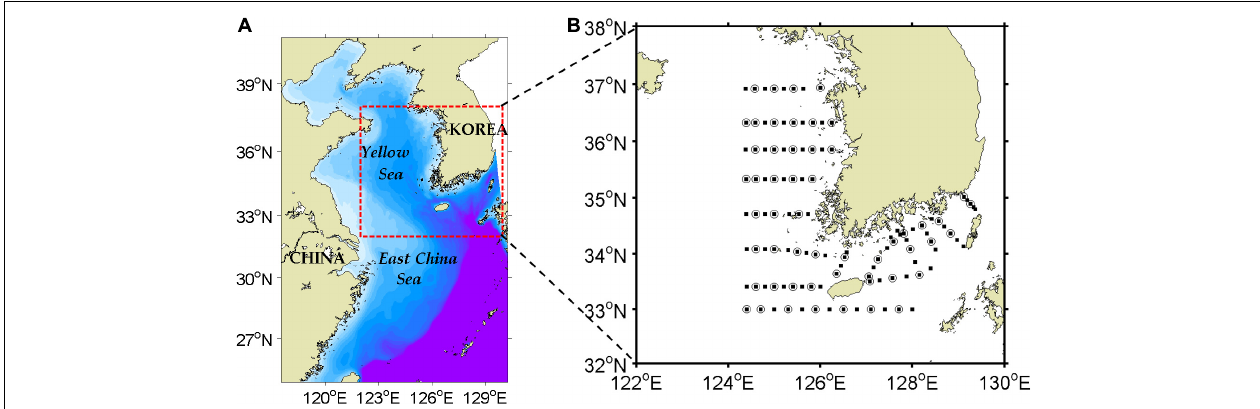
FIGURE 2 | Model domain (A) and routine observation stations (B) taken by the National Institute of Fisheries Science, Korea. Stations for temperature and salinity are denoted by filled squares, and stations for NO 3 - are denoted by open circles. The blue dashed box (zonally from 121.5 to 125.5 ◦ E and meridionally from 34.5 to 39.5 ◦ N) in (B) denotes the region of the central YS where chlorophyll- a from the model was compared with satellite data for model validation.